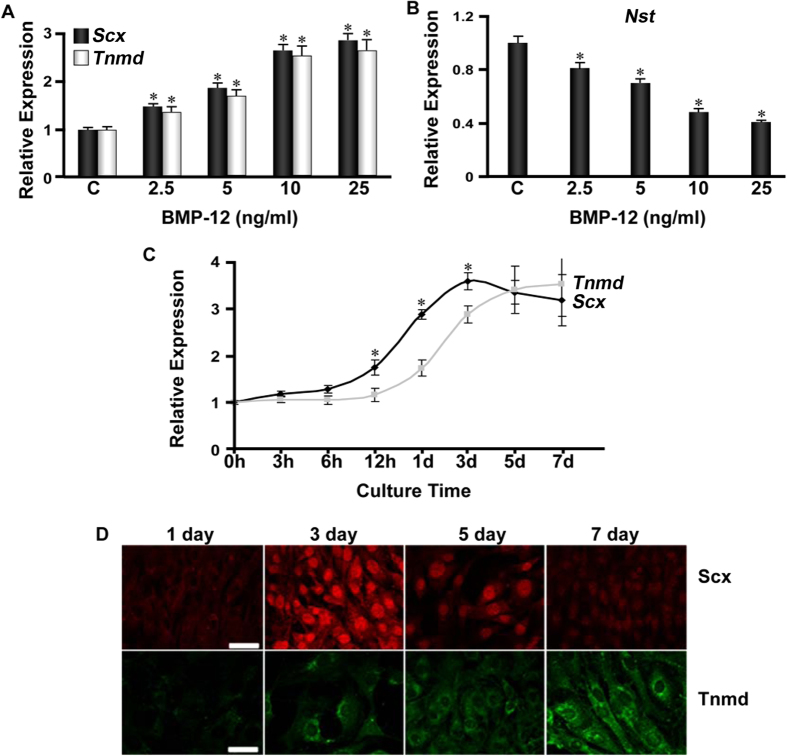
Induction of scleraxis and tenomodulin by BMP-12 in C3H10T1/2 stem cells.(A) Upregulation of Scx and Tnmd. (B) Downregulation of Nst Expression. Cells were left untreated or treated with different concentrations of BMP-12 for 24 hours. mRNA levels were determined by RT-qPCR. Data are expressed as mean ± S.D. (n = 6). *p < 0.05. (C,D) Time course of Scx and Tnmd expression. Cells were treated with 10 ng/ml of BMP-12 for different lengths of time. mRNA (C) and protein (D) levels of gene expression were determined by RT-qPCR and immunostaining, respectively. Data in (C) are expressed as mean ± S.D. (n = 3).